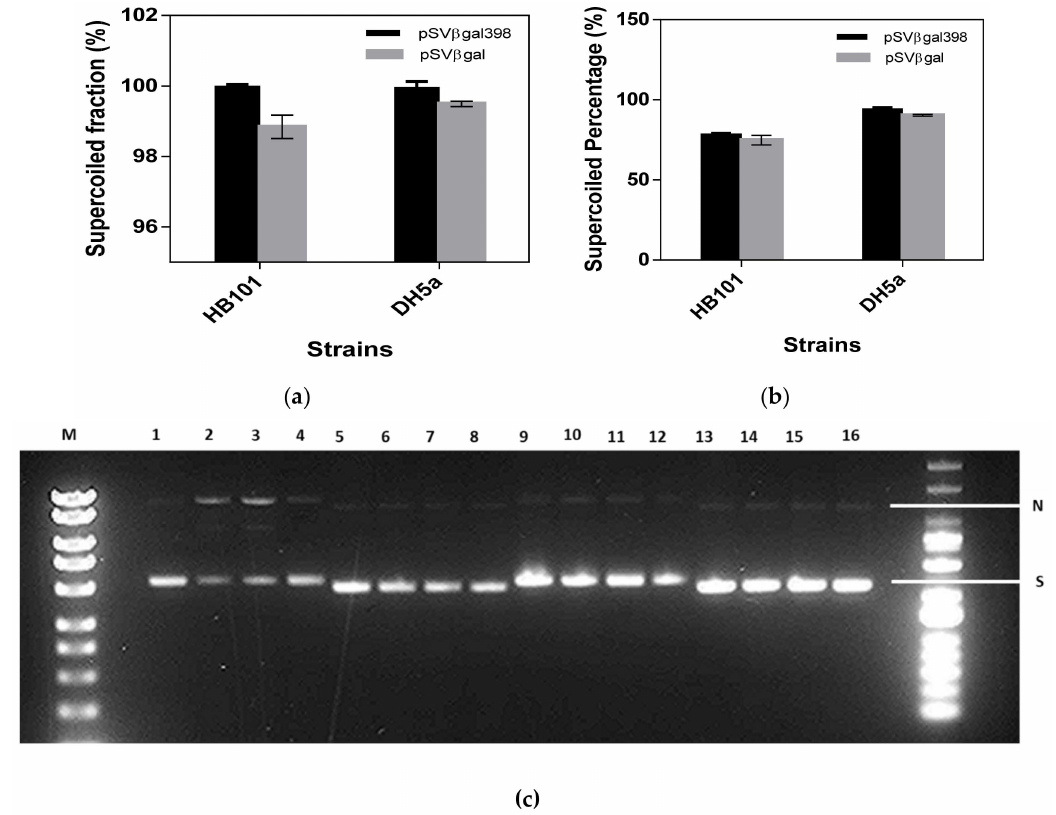
Figure 4. ( a ) Supercoiled topoisomer content after exposure to shear using the USD shear device, expressed as a fraction of the control (supercoiled content of non-sheared sample), n = 3 ( b ) Supercoiled content of the control sample before shearing. ( c ) Gel image of the samples after shearing. M